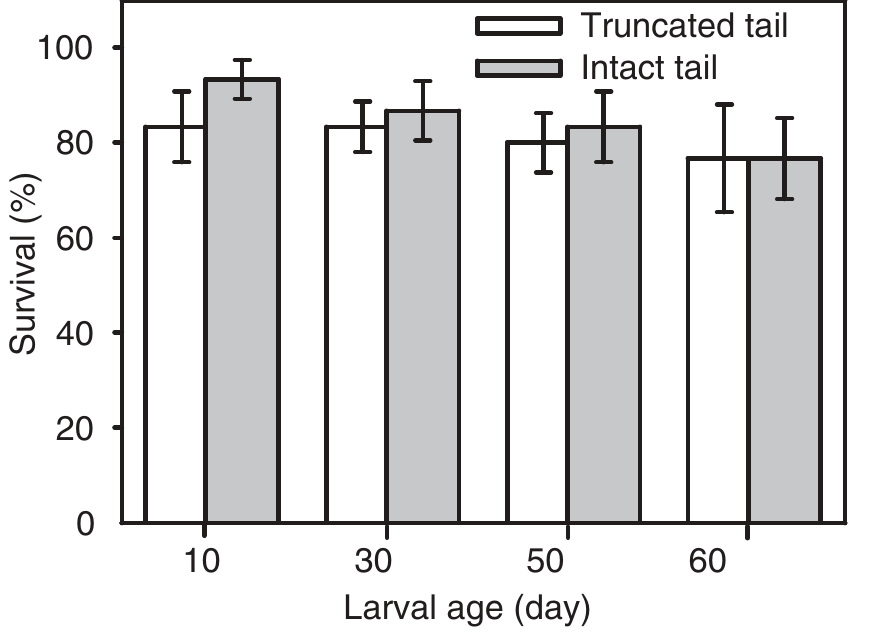
Fig 3. Tail clipping effects on survival of Salamandra infraimmaculata larvae. Mean ( ± SE) larval survival per tub 10, 30, 50, and 60 days from the start of the